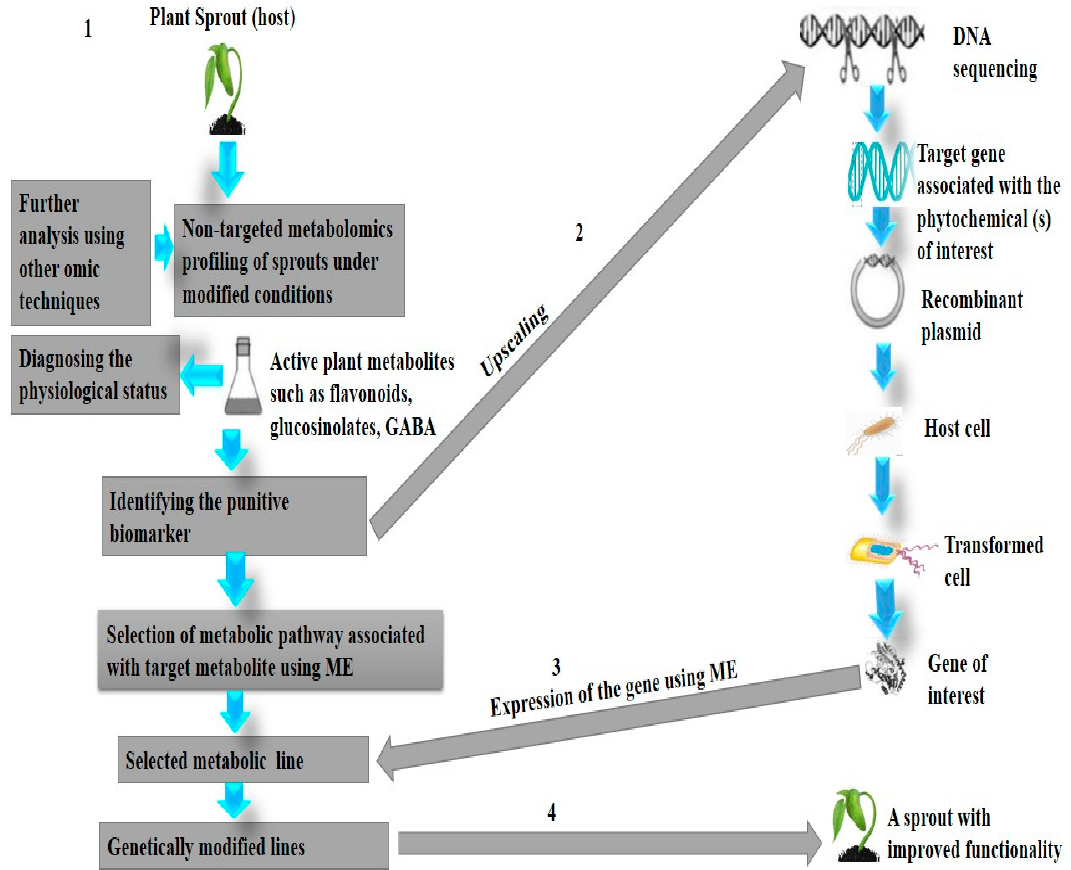
Figure 2. Proposed systematic steps to achieve high-yield production of sprout phytochemicals utilizing M.E. ( 1 ) Identifying target metabolite(s) in the sprout using various techniques. ( 2 ) The protein associated with the selected biomarker is identified and upscaled using the recombinant DNA technology. ( 3 ) Specific metabolic pathway(s) associated with the target phytochemical is manipulated by expressing the gene of interest. ( 4 ) Eventually, M.E results in an engineered sprout with improved activity for the targeted metabolite.